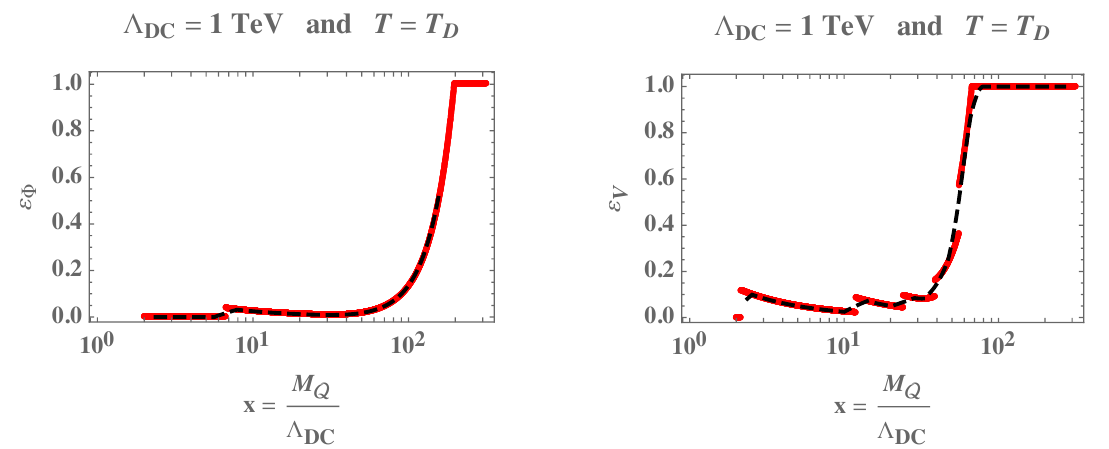
Figure 7 . Suppression factors " (cid:8) (left panel) and " V (right panel) at T (cid:16) T D as a function of the ratio M { (cid:3) DC for (cid:3) DC (cid:16) 1 TeV. In red the results of the numerical computation and in black the Q interpolation used to compute the relic density. Discontinuities in the numerical results are due to the integer nature of l (cid:6)